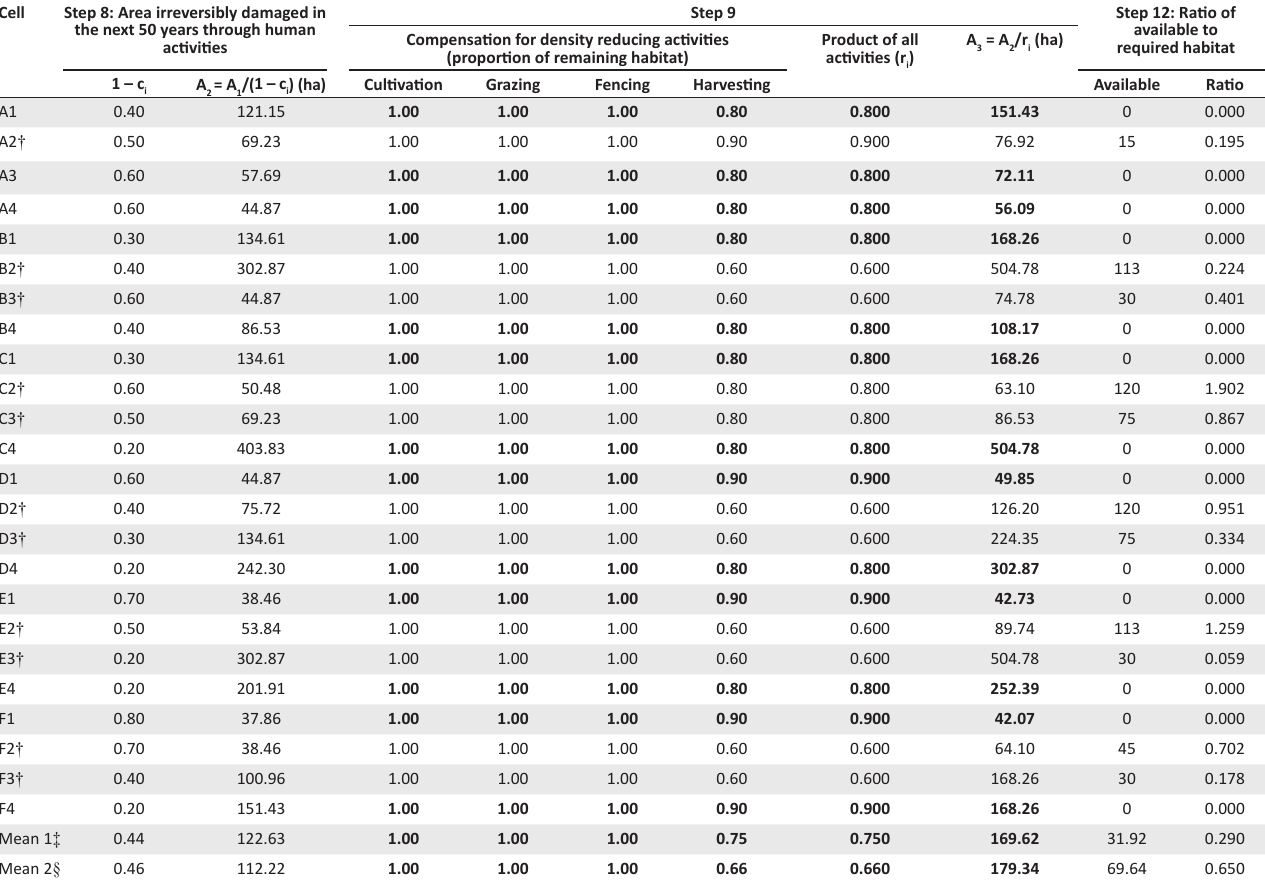
TABLE 2e: Brackenridge zanguebarica minimum conservation area size using Burgman et al. ’s method (Steps 8, 9 and 12): Scenario 4 – Only bark harvesting